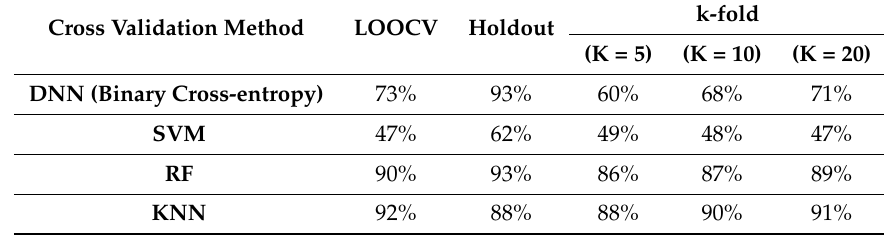
Table 8. Accuracy results of preference detection with DNN, RF, KNN, and SVM using different cross validation methods.